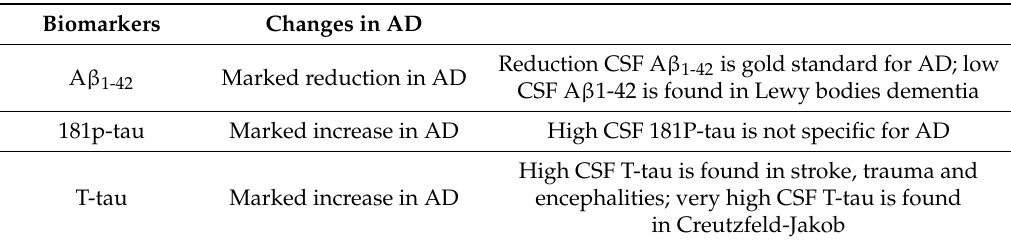
Table 1. Biomarkers and their changes in Alzheimer disease